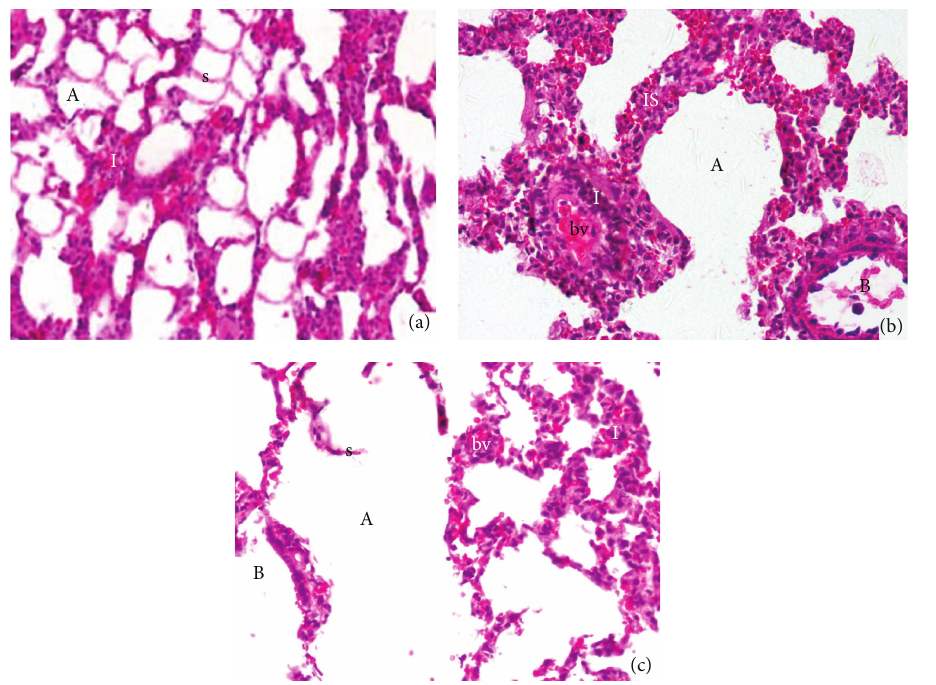
Figure 2: (a) A photomicrograph of transverse section in the control rat lung shows normal architecture of alveoli (A) with thin interalveolar septa (s) and normal interstitial tissues (I) (H&E × 400). (b) A photomicrograph of transverse section in the second group rat lung shows marked thickening of interstitial tissues (IS) with numerous areas of cellular infiltration (I), congested blood capillaries (bv), and bronchiole (B) with widening alveoli (A) (H&E × 400). (c) A photomicrograph of transverse section in the third group rat lung shows loss of normal architecture, cellular infiltration (I), fragmentation and degeneration of alveoli and interalveolar septum (s) with a subsequent compensatory dilatation of alveoli (A), thickened and congested pulmonary blood vessels (bv), and degenerated bronchiolar wall (B) (H&E × 400).